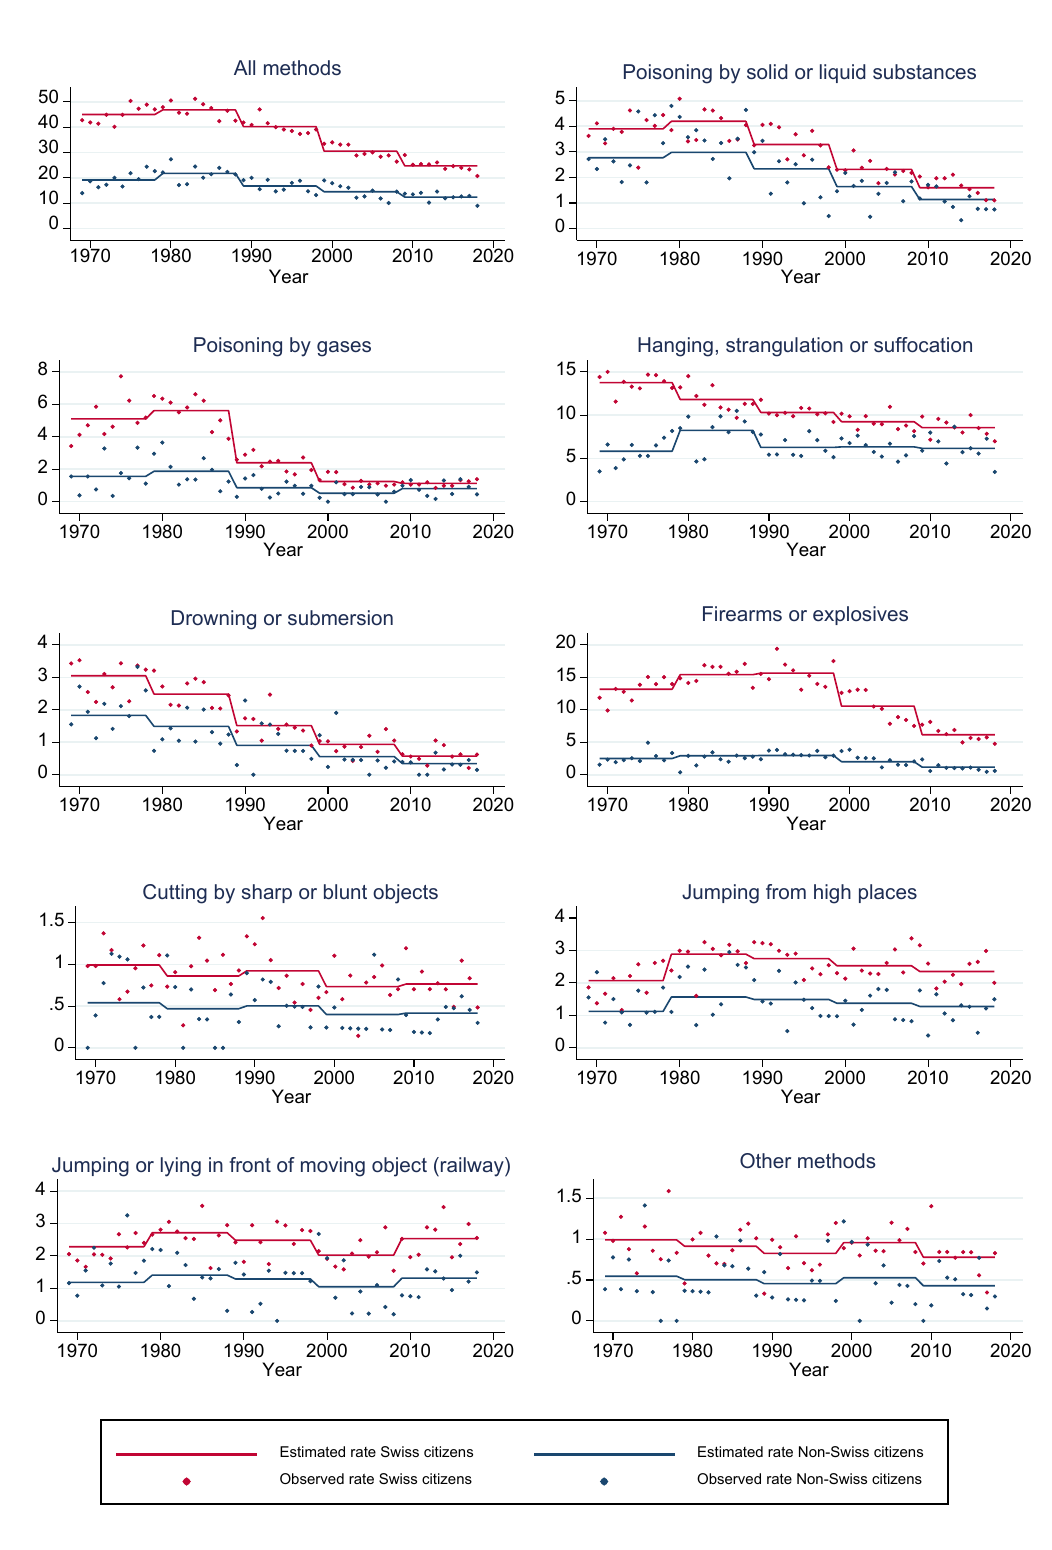
Figure S5. Rates of suicide methods per 100'000 population (person-years) in 30-64 years old